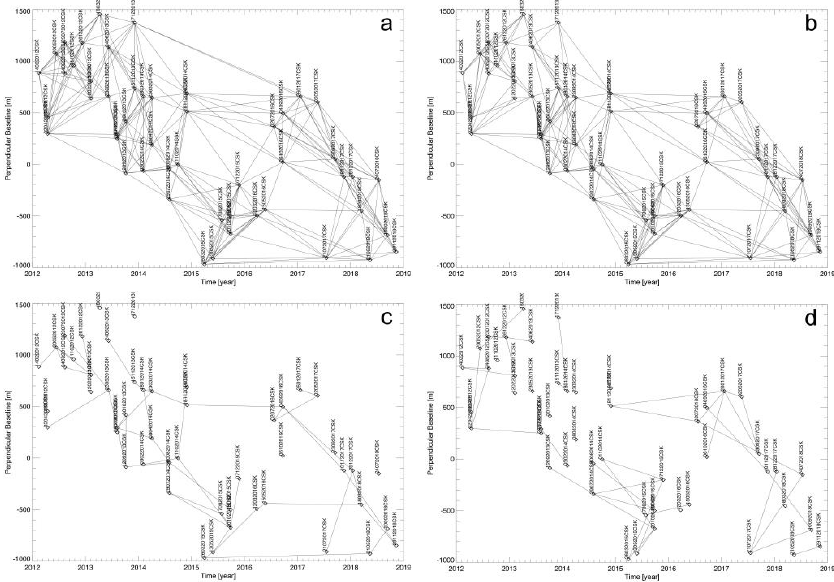
Figure 12. (a)-(d) InSAR distribution in the temporal/perpendicular baseline plane related to the SAR Figure 12. ( a )–( d ) InSAR distribution in the temporal / perpendicular baseline plane related to the SAR pixels labelled as I, II, III, and IV in Figure 11. pixels labelled as I, II, III, and IV in Figure